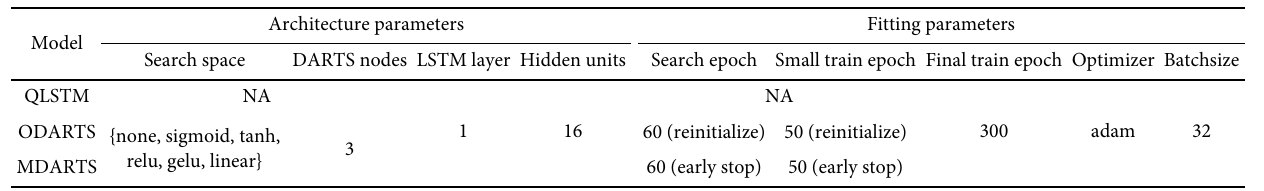
Table 2 Important parameters